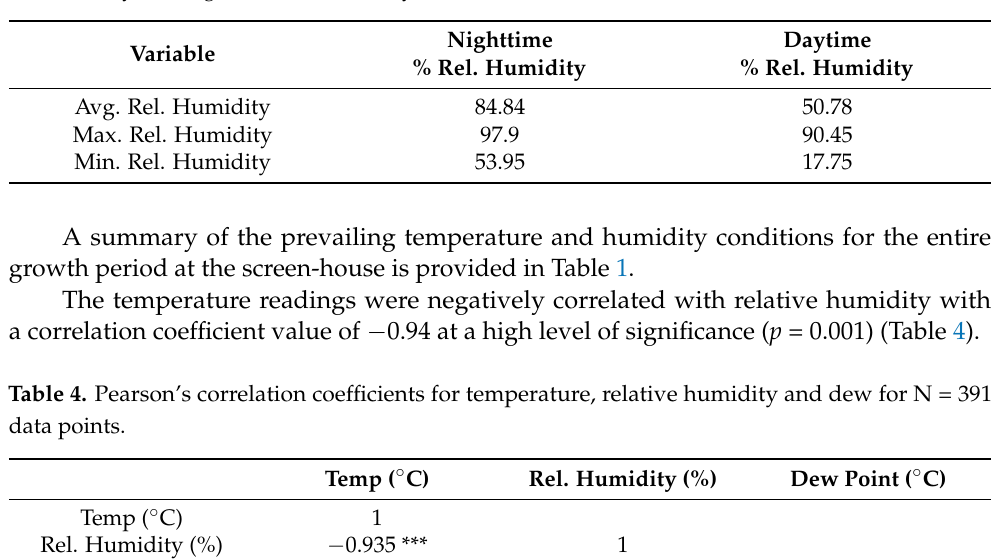
Daytime % Rel. Humidity